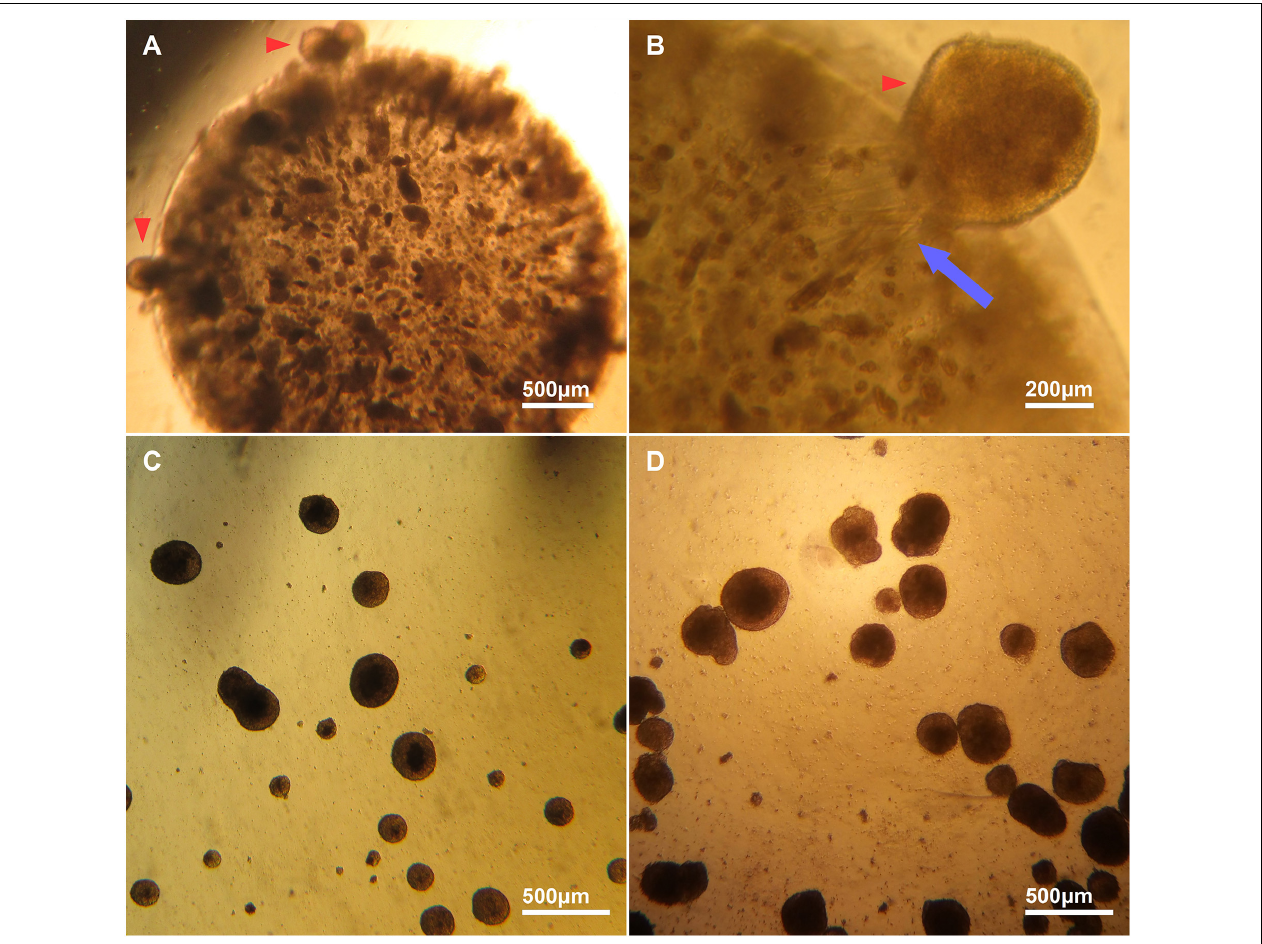
FIGURE 2 | Brightfield images of encapsulated and escaped cell aggregates from alginate and EBs. (A) Representative image of aggregate formation by encapsulated ESCs inside an alginate bead. (B) A high magnification image of an aggregate migrating out of an alginate bead (red arrowhead). The escaped aggregates migrated out of the beads as whole aggregates, and appear to interact with the alginate matrix, forming striations in the bead (blue arrow). (C) Cell aggregates formed inside an alginate bead that have migrated out and are free-floating in medium. (D) Canonical EBs are similar in size and shape to cell aggregates that escape from alginate: DMEM